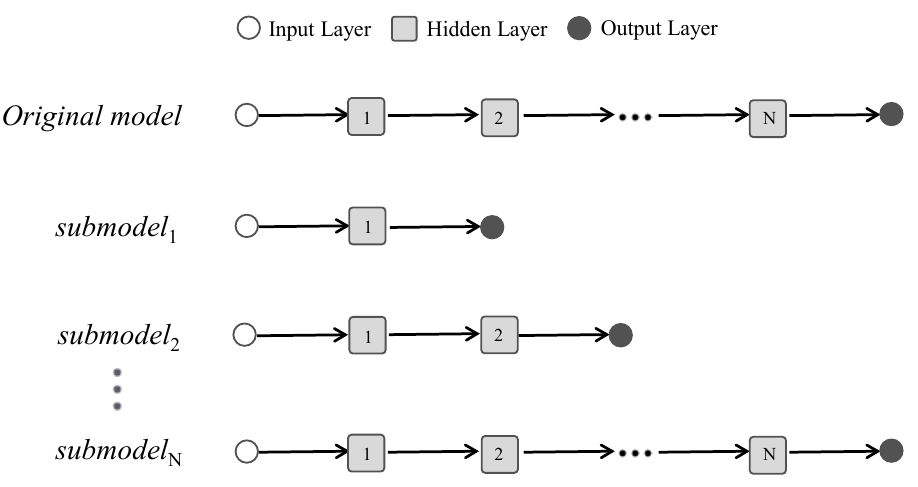
Figure 3. N sub-models of a classifier with N hidden layers Each sub-model is an independent classifier with fewer hidden layers. Its outputs thus reflect the intermediate classification results of the original classifier. A sub-model takes the i th hidden layer of the original classifier as input and outputs classification results in the same form as the original